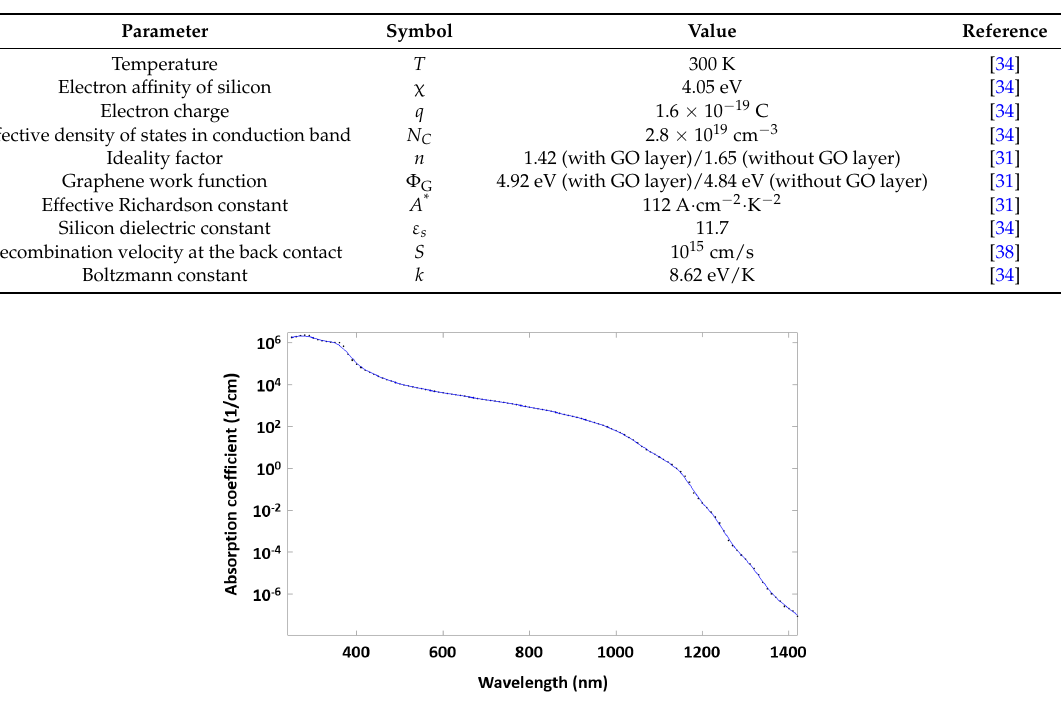
Table 1. Model parameters.